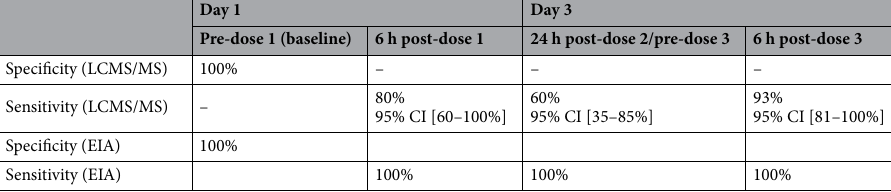
Table 3. Sensitivity and specificity of detecting LNG in urine samples of COC users (n =